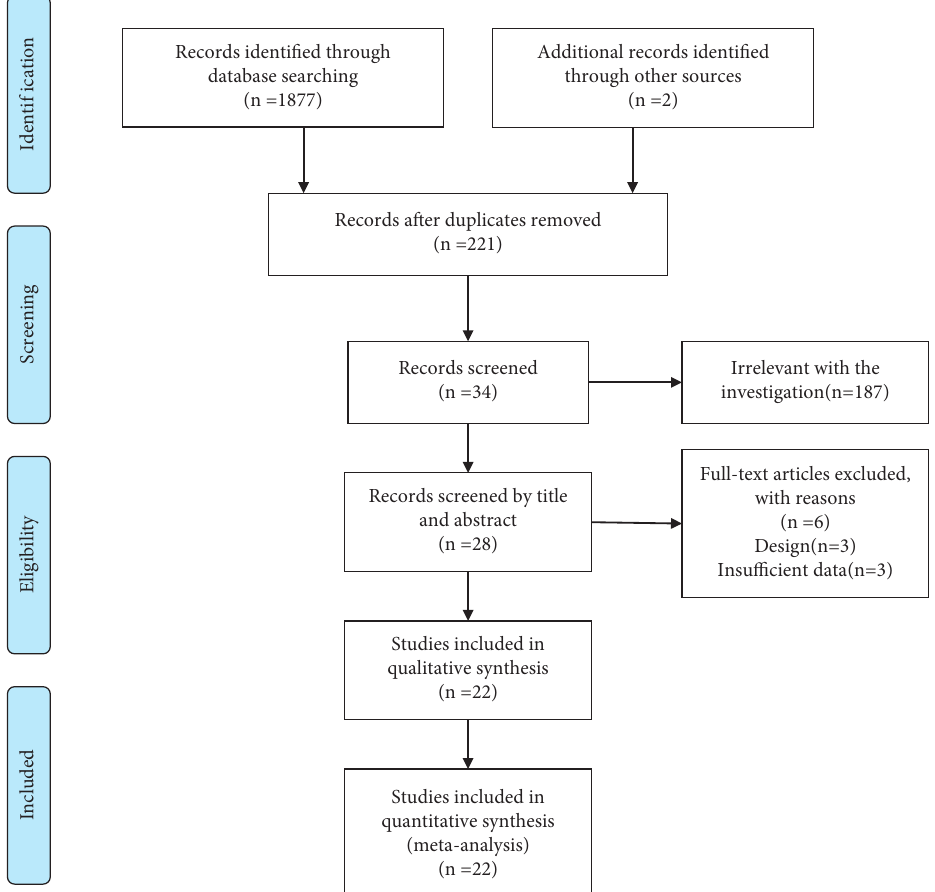
Figure 1: An illustration of the flow at each stage of the